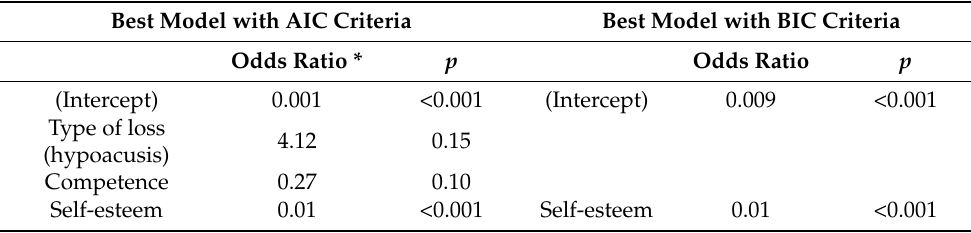
Table 5. Logistic regression coefficients (transformed to odds ratio) for two alternative models to predict abandonment of hearing aids and cochlear implant, selected with a best regression procedure using AIC and BIC as goodness-of-fit